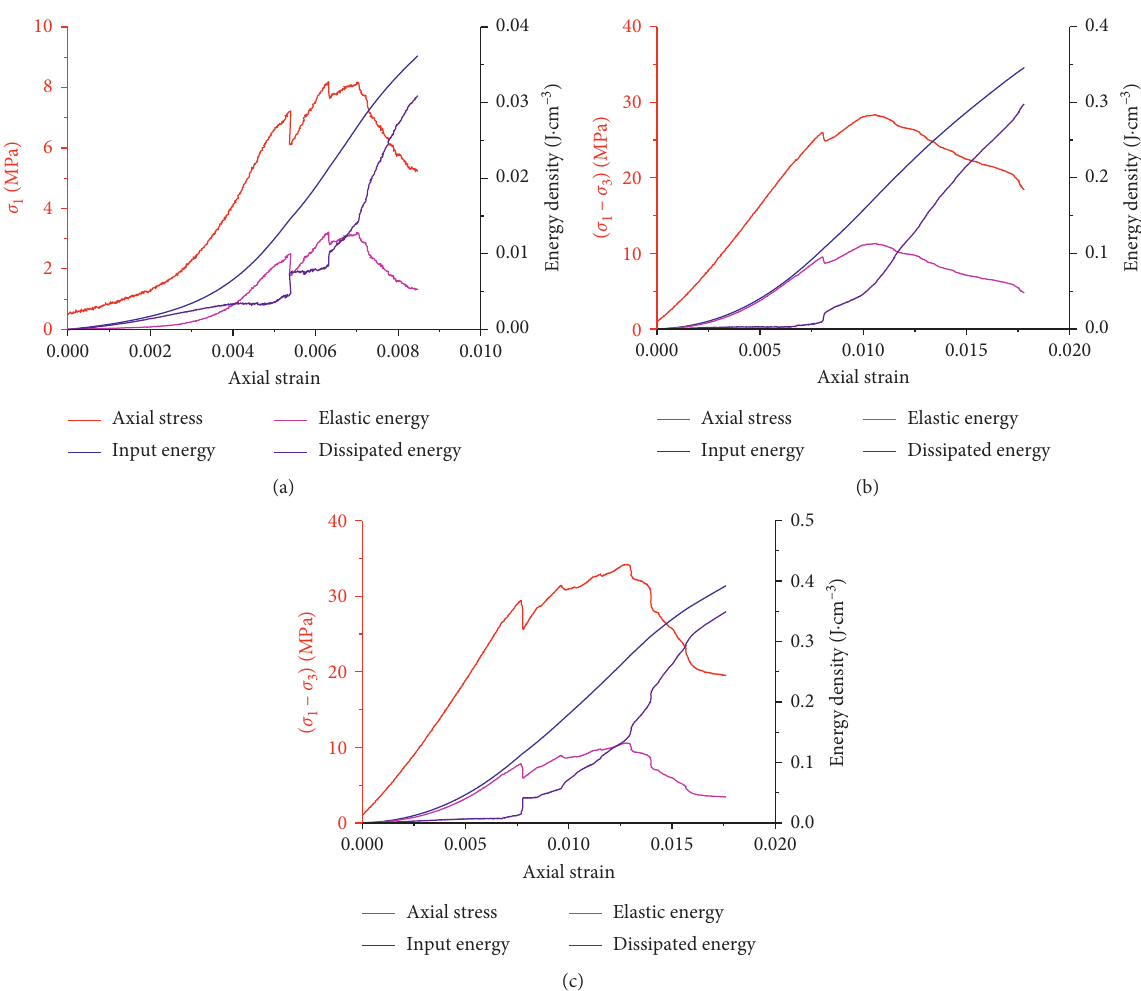
Figure 6: Energy evolution curves of coal specimens in a conventional compression test. (a) 0 MPa. (b) 3 MPa. (c)